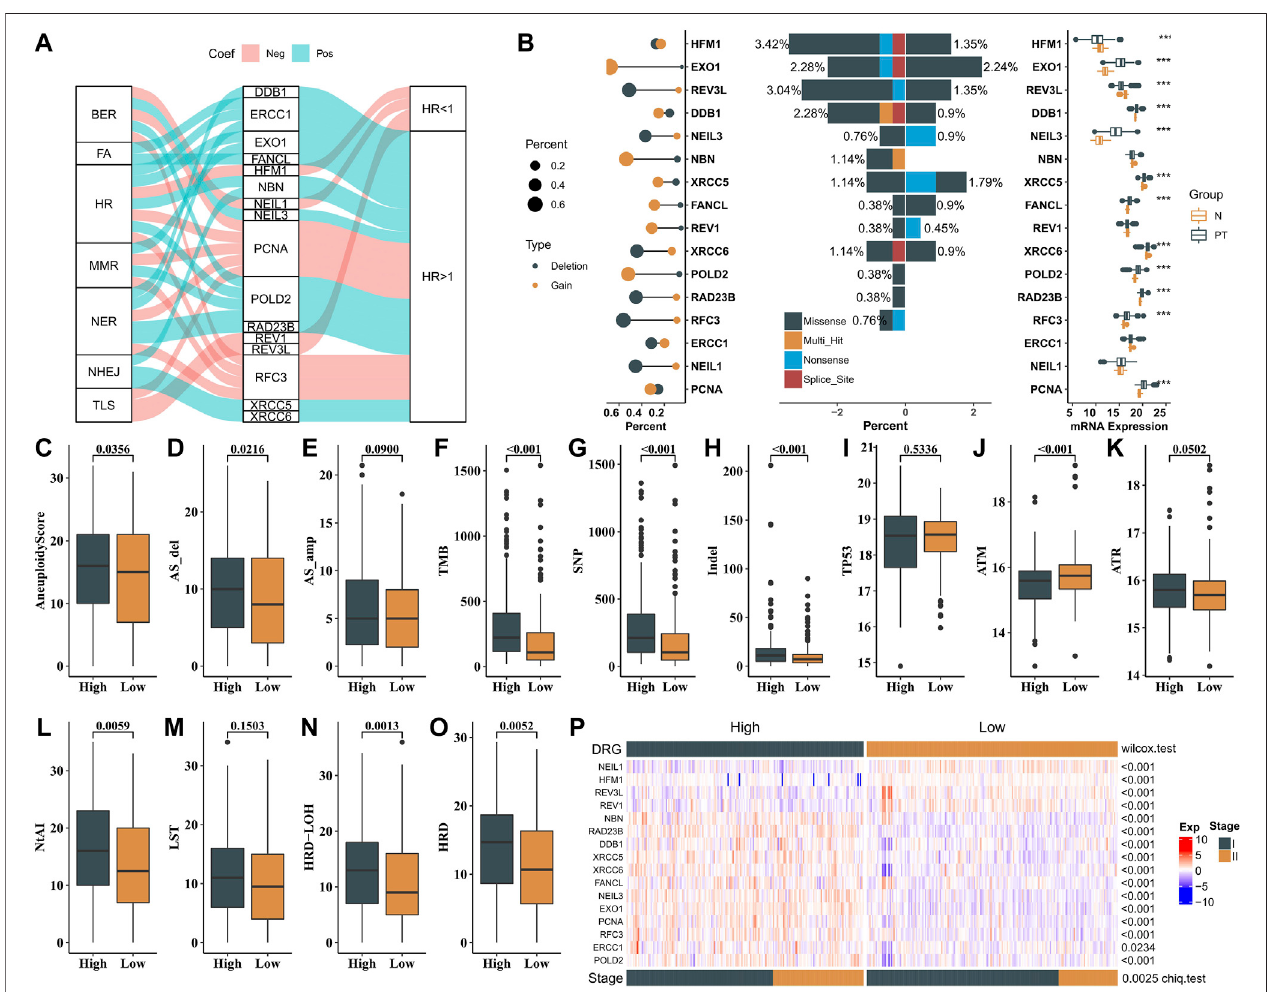
FIGURE2| Mechanismofvalidationinmutation,CNV,mRNAexpression,andgenomeinstability. (A) Sankeyplotshowingthecorrelationsamong16genes,DDR pathways, and prognostic value. (B) Left panel is the CNV variation frequency of 16 genes, and the deletion frequency is shown by gray dots; the middle panel is the mutation frequency of 16 genes between high- and low-DDR score samples. The right panel is the expression of 16 genes between normal tissues and tumor tissues. Tumor, gray; normal, yellow. (C – O) Comparison of the genome instability (NtAI, LST, LOH, HRD, Aneuploidy Score (AS), AS_del, AS_amp, TMB, SNP, and indel) andexpression patternofTP53,ATM,andATRbetweenhigh-riskandlow-riskpatientsintheTCGAdataset.High,gray;low,yellow. (P) Expressionpro fi lesof16genes betweenhigh- and low-risk groups inthe stages Iand IITCGA – LAUD dataset. p -value ofcontinuous variables wastested using Wilcoxon rank-sum test. Pearson ’ schi- square test was used to test the categorical